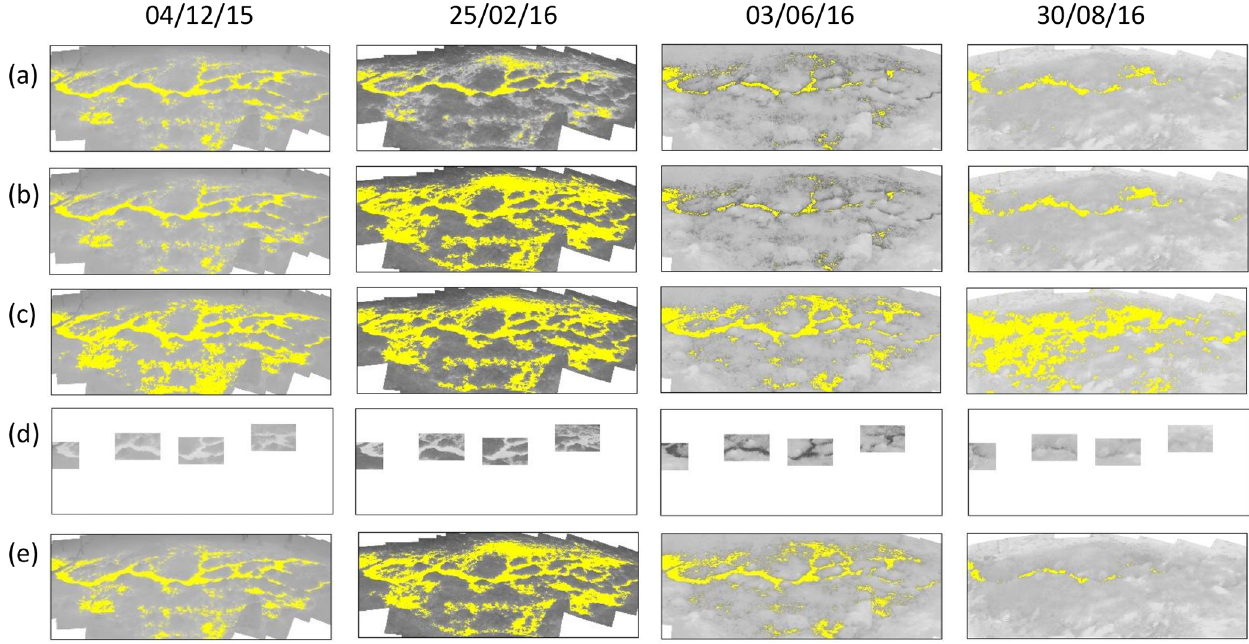
Figure 8. Comparison of saturation maps (yellow represents saturation), generated with a region-growing process whose seeds and stopping criteria were automatically constrained to (a) bimodal distributions derived from the HBSA applied to the entire image, (b) bimodal distri- butions derived from the HBSA where the selection of bimodal image subsections was constrained to image-specific manual predefinitions of temperature ranges of saturation, and (c) bimodal distributions derived from preselected parts of the image (which include clearly wet and dry areas and are shown in d ). The saturation maps generated with manually selected temperature ranges based on visual assessment (cf. Fig. 7; green asterisk) are shown for comparison (e) . As a reference for the spatial dimension of the images, we refer the reader to the indicated stream section in Fig. 3 or